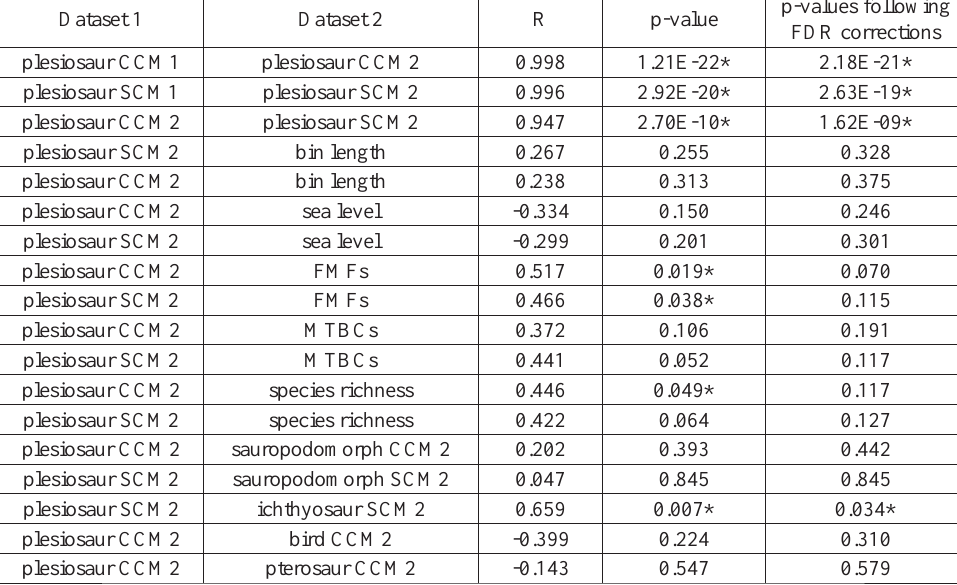
Table 2. Results of pairwise comparisons between time series using Pearson’s product-moment correlation coefficients. All time series were log-transformed and subjected to generalised differencing prior to comparisons being made. Asterisks indicate statistically significant results. Abbreviations: CCM, character completeness metric; FDR, false discovery rate; SCM, skeletal completeness metric (for detailed explanation of terms see Completeness metrics in Methods section).